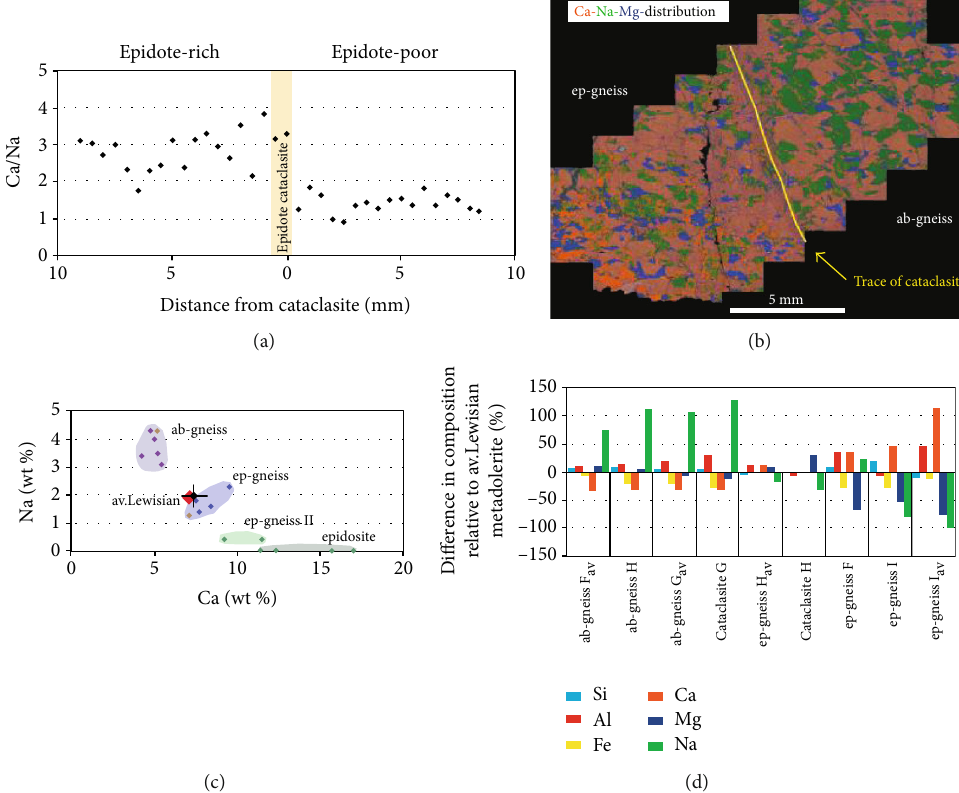
Figure 8: (a) Traverse showing Ca/Na ratio of the metabasic gneiss on either side of an epidote-bearing cataclasite (thin section H). Position of large fracture containing hornblende-epidote cataclasite marks the boundary between plagioclase (albite) gneiss to the right and epidote gneiss to the left; (b) X-ray distribution map showing Ca distribution in orange-red shades, Na distribution shown in dark green shades, and Mg distribution shown in blue (thin section H). Note the fracture trace itself has a similar composition to the epidote gneiss; (c) plot showing Na and Ca contents of di ff erent whole rock compositions of the gneisses relative to average metabasic gneiss (large red diamond) in the Lewisian [56] and metabasic gneisses lacking evidence of retrogression from Iona (black diamond with standard deviations represented by error bars, based on 16 samples) [40]. Cataclasite compositions within both albite- and epidote-gneisses are shown by orange diamonds. Epidote gneiss II represents gneiss composition immediately adjacent to epidosites; (d) comparison of major element chemistry of di ff erent retrogressed samples of metabasic gneisses with average Lewisian metabasic gneiss [56]. Values above the line represent enrichments; those below the line represent